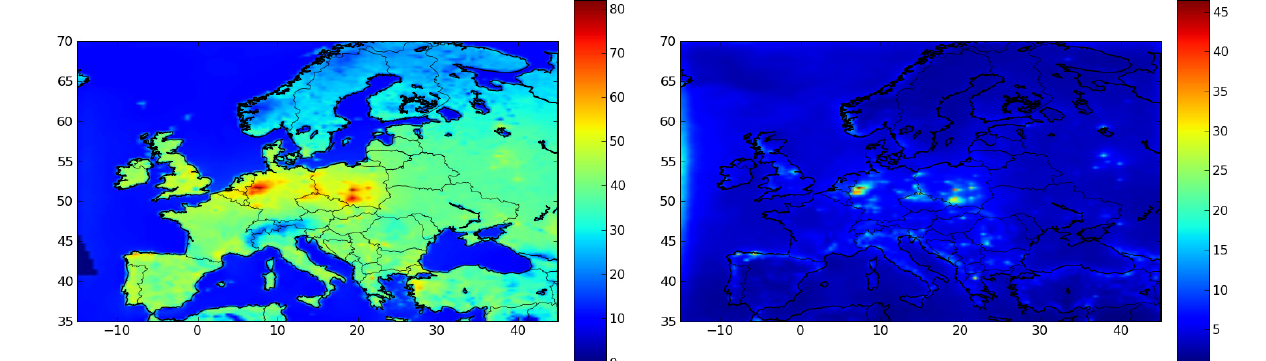
Figure 7. ( Left panel ) Dry deposition of mercury over Europe in 2005. ( Right panel ) Wet deposition of mercury over Europe in 2005. Units: g ∙km −2 ∙yr −1